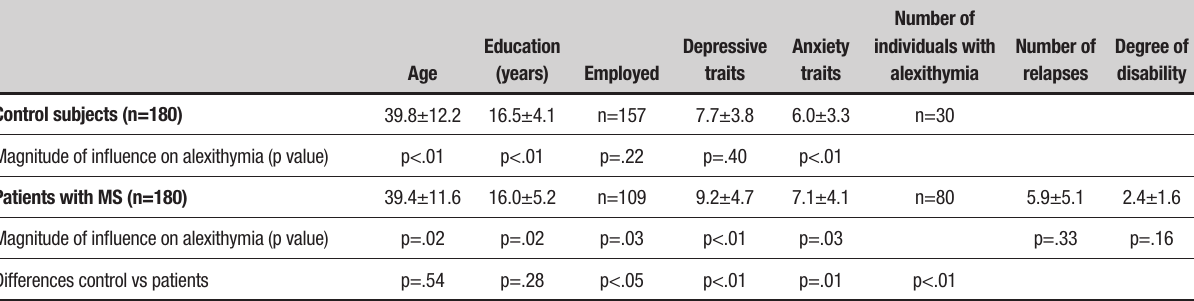
Table 1. Alexithymia in multiple sclerosis (MS). Degrees of depression, anxiety and alexithymia in control subjects and patients with multiple sclerosis (MS). Values expressed as mean ± standard